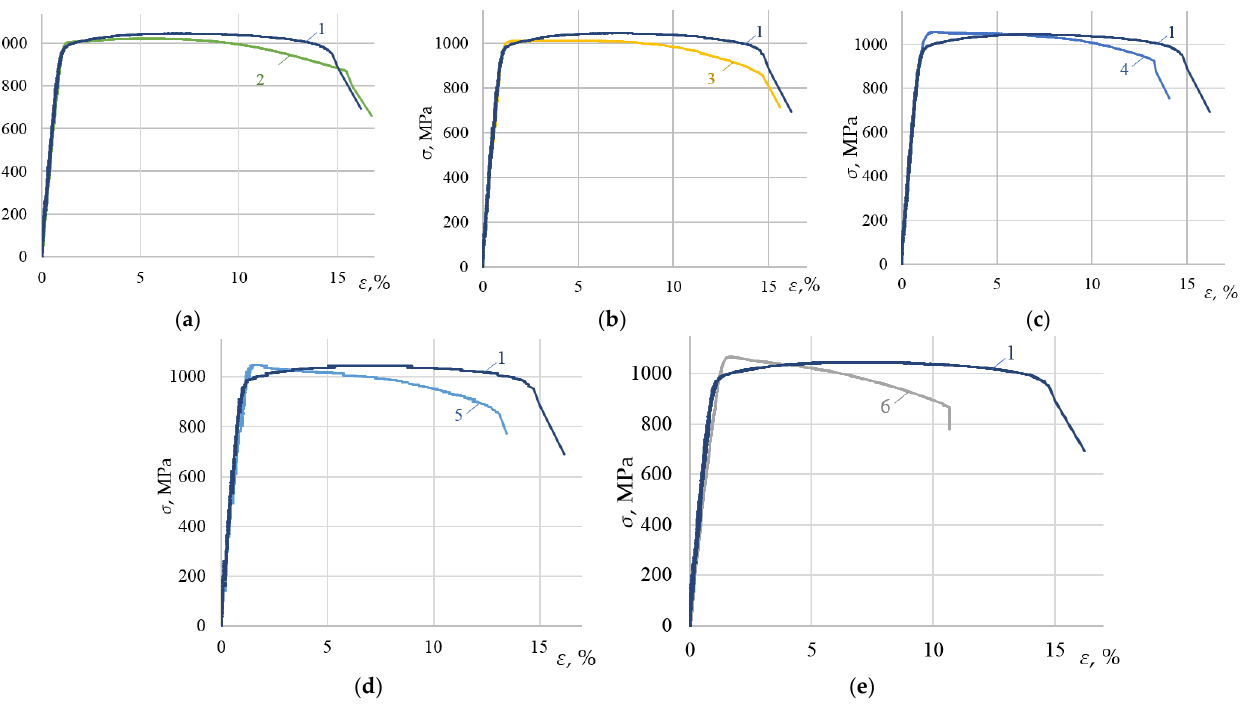
Figure 3. Stress–strain diagrams of the VT23 titanium alloy rolled in the transverse direction after the DNP and subsequent static tensioning, as compared to the static tensioning in the initial state (curve 1): ( a ) (2— ε і mp = 0.81%); ( b ) (3— ε і mp = 1.44%); ( c ) (4— ε і mp = 2.56%); ( d ) (5— ε і mp = 4.56%); ( e ) (6— ε і mp = 5.5%).